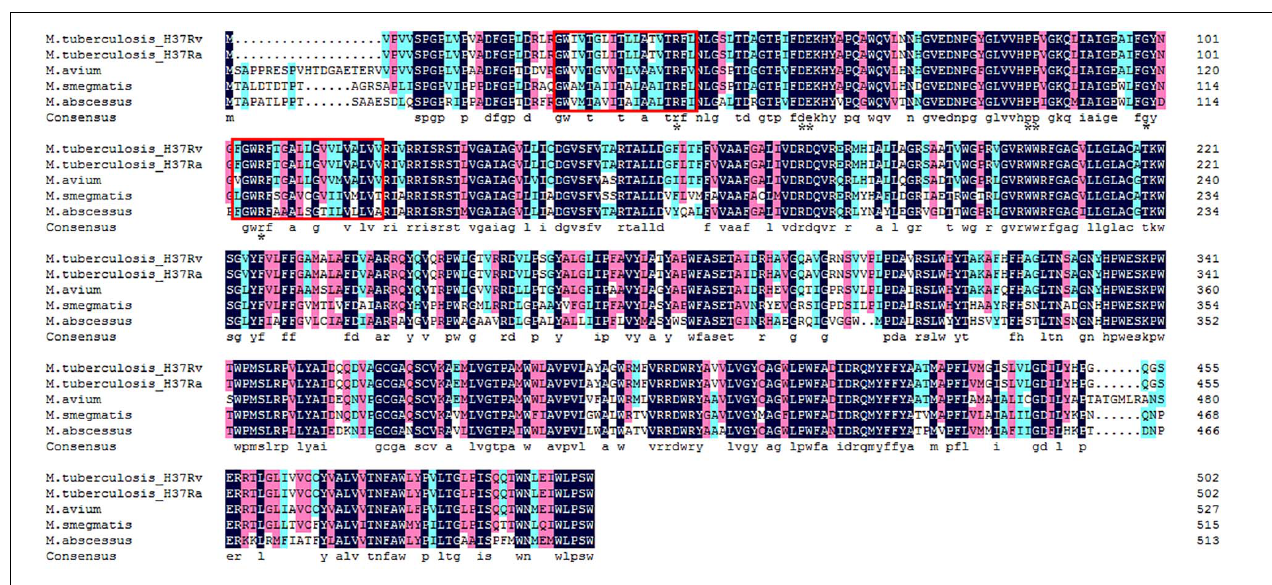
FIGURE 1 | Amino acid multiple-sequence alignment of O-mannosyltransferase in mycobacterium species. GenBank accession numbers: M. tuberculosis H37Rv: CCP43752; M. tuberculosis H37Ra: ABQ72745; Mycobacterium avium : ANR90417; M. smegmatis : AFP41739; and M. abscessus : WP_005059031. The dark blue box indicates 100% identical of amino acid sequence among five mycobacterium strains. The pink and sky blue colors indicate > 75 and > 50% similarity of amino acid sequence among five mycobacterium strains, respectively. Two functional transmembrane domains of PMT were framed by the red box, and the conserved PMT active site residues were marked with the black star based on the VanderVen study in 2005. Alignment was conducted using DNAMAN